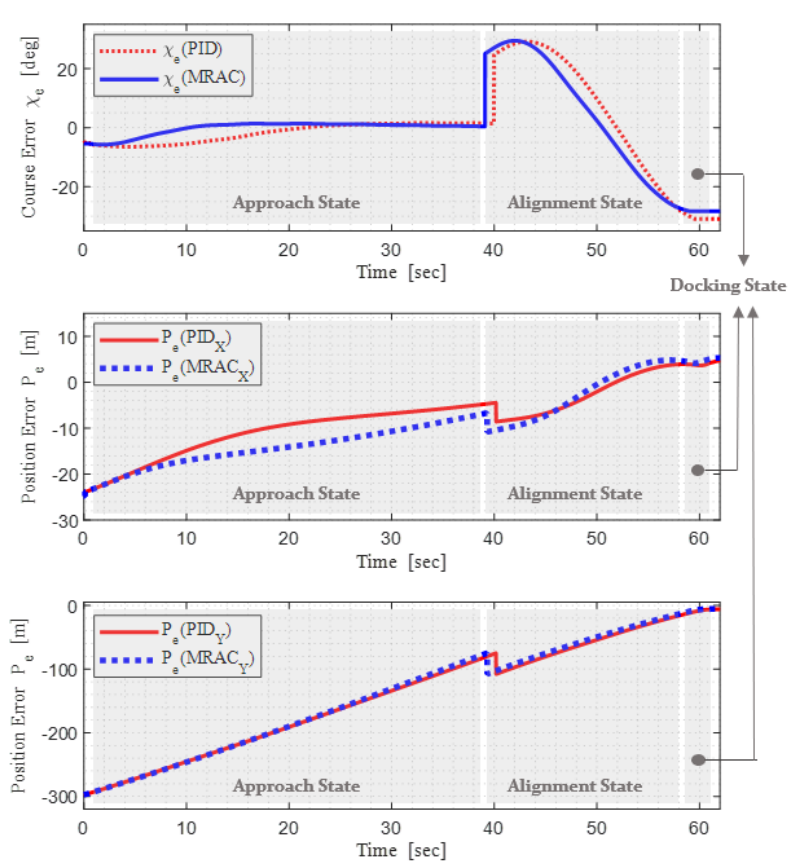
Figure 12. Comparison of errors between the case of using only the PID controller and the case of using MRAC in each state during simulation.